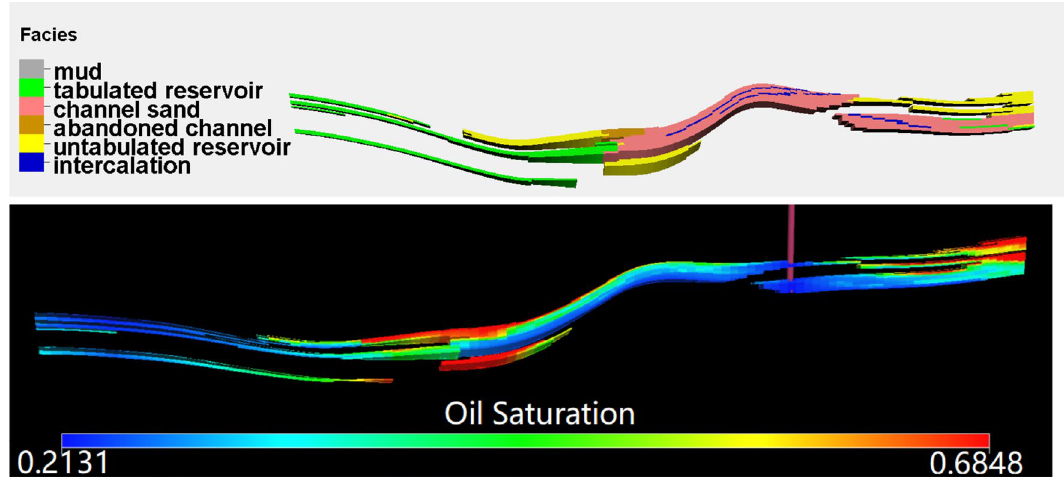
Fig. 12 The profile 3 of facies model and oil saturation simulation result in study area. a Profile 3 of facies model; b profile 3 of oil saturation simulation result set in study